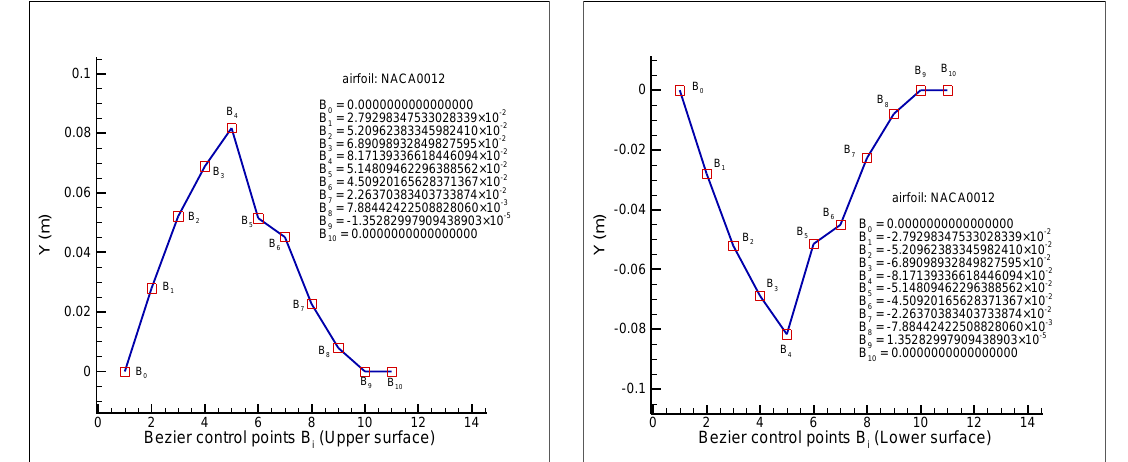
Figure 3. Definition of the design variables used for aerodynamic shape optimization. Here, the coordinates of the Bezier control points were not real and were plotted this way for the sake of simplicity in the definition.